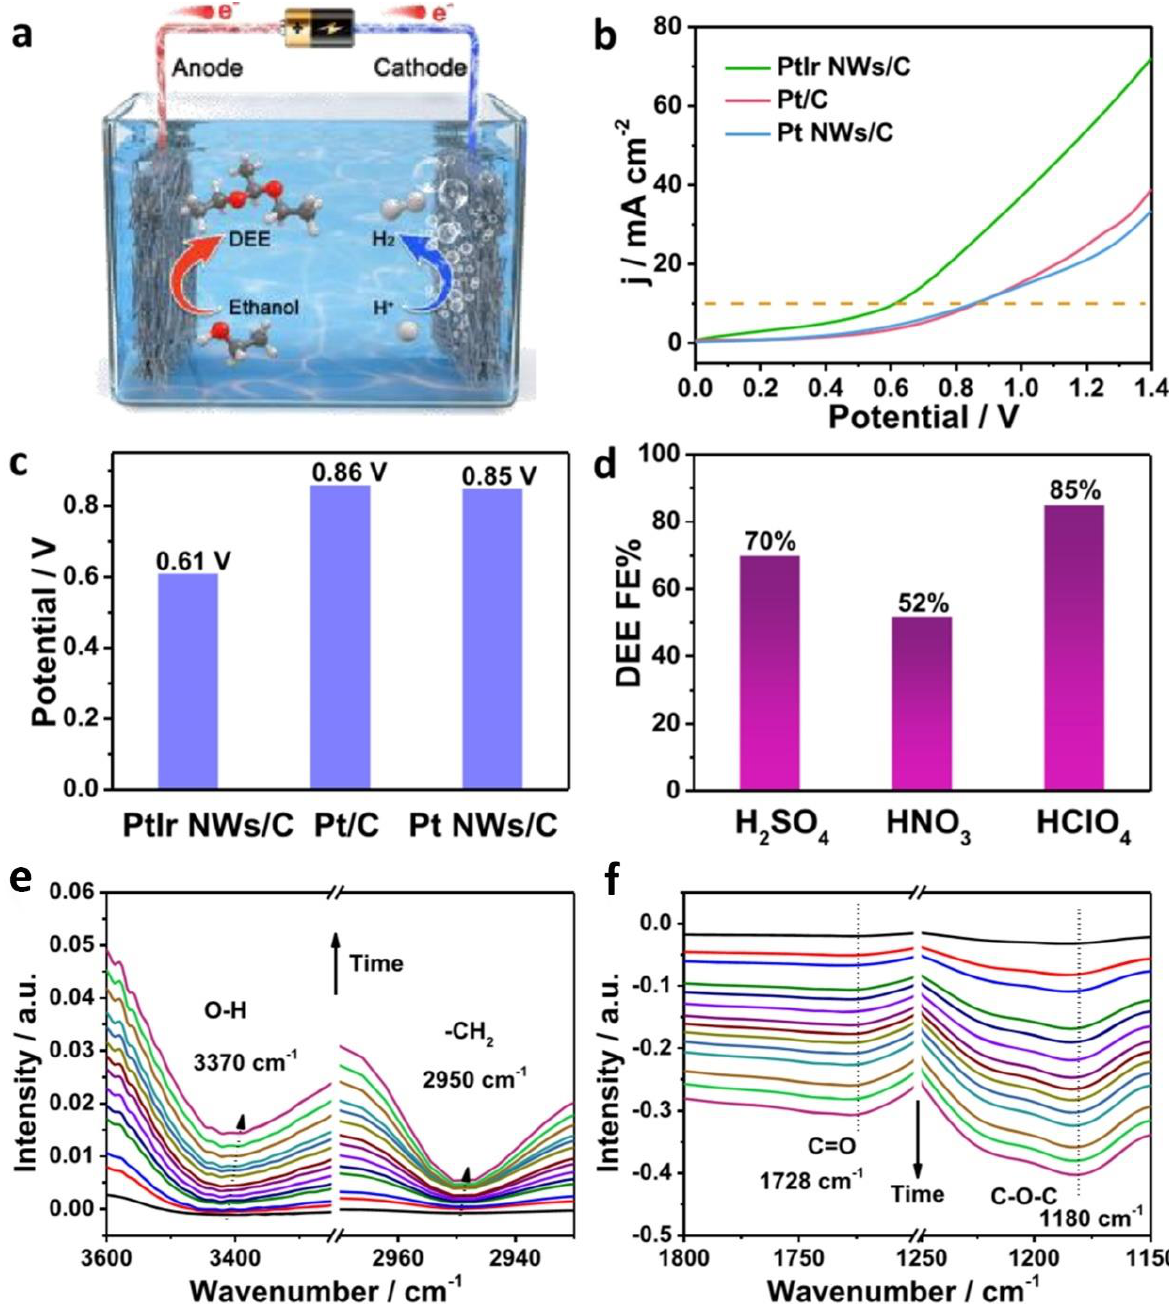
Figure 2. ( a ) Schematic illustration of the hybrid electrolyzer with the oxidation of ethanol to DEE and hydrogen production. ( b ) LSV of the Pt/C||Pt/C, Pt NWs/C||Pt NWs/C and PtIr NWs/C||PtIr NWs/C cells at a scan rate of 5 mV s − 1 in 0.5 M H 2 SO 4 ethanol solution (the dotted line refers to current density of 10 mA cm − 2 ). ( c ) Potential comparation (j = 10 mA cm − 2 ), ( d ) the FE of DEE in various acids (V = 1.4 V). ( e , f ) In situ FTIR spectra characterization of the ethanol electrooxidation for DEE production over PtIr NWs/C (the different colored lines in ( e , f ) refer to the curves at various time in the direction of the arrow). Reproduced with permission, Copyright 2021 [26], American Chemical Society (ACS) Publishing Group.